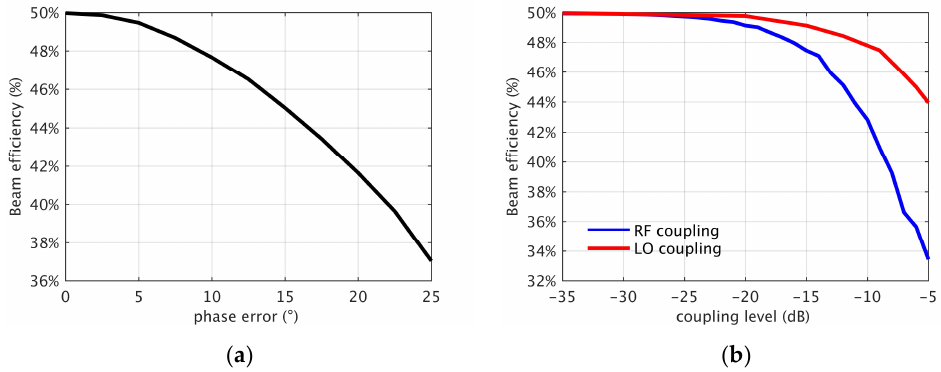
Figure 9. ( a ) Variance of beam efficiency varies with phase error; ( b ) variance of beam efficiency with coupling level, and a comparison of the effects of RF and LO coupling.